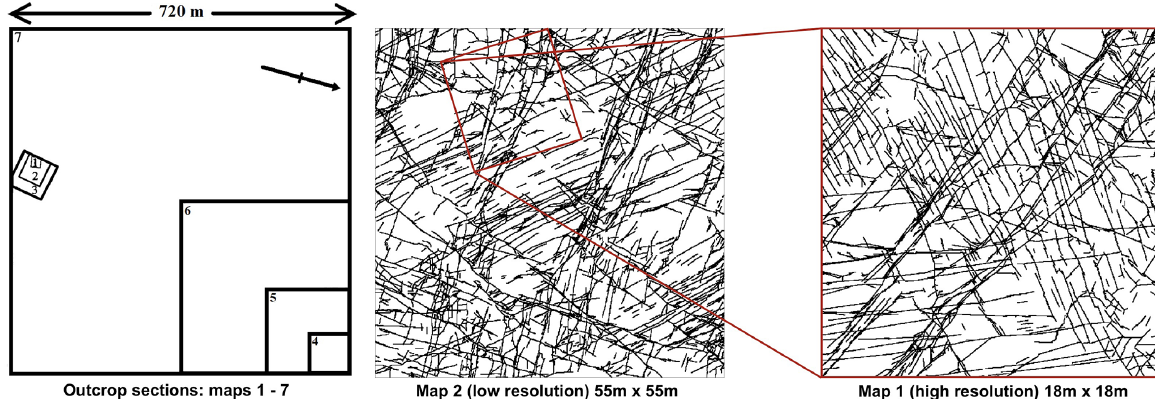
Figure 7. Illustration of mapping technique of natural fracture map and its dominant sub-network map (modified from Odling, 1997).